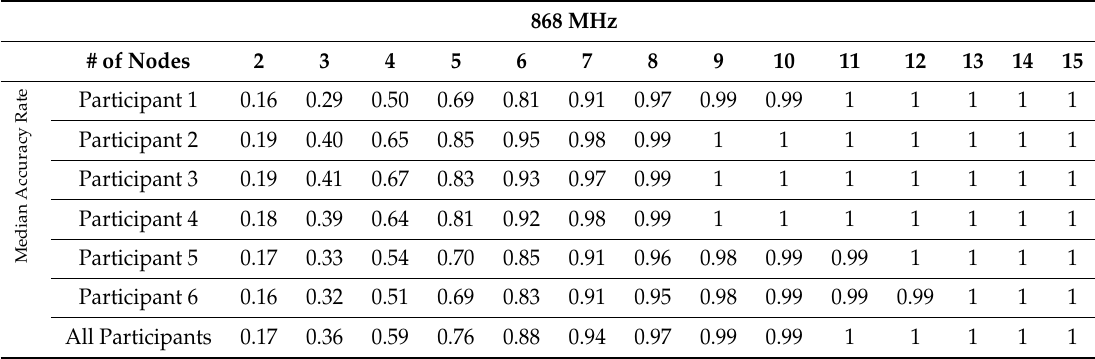
All Participants Table 4. Median accuracy rates obtained by using a naive Bayesian classifier on data from the 868 MHz network.